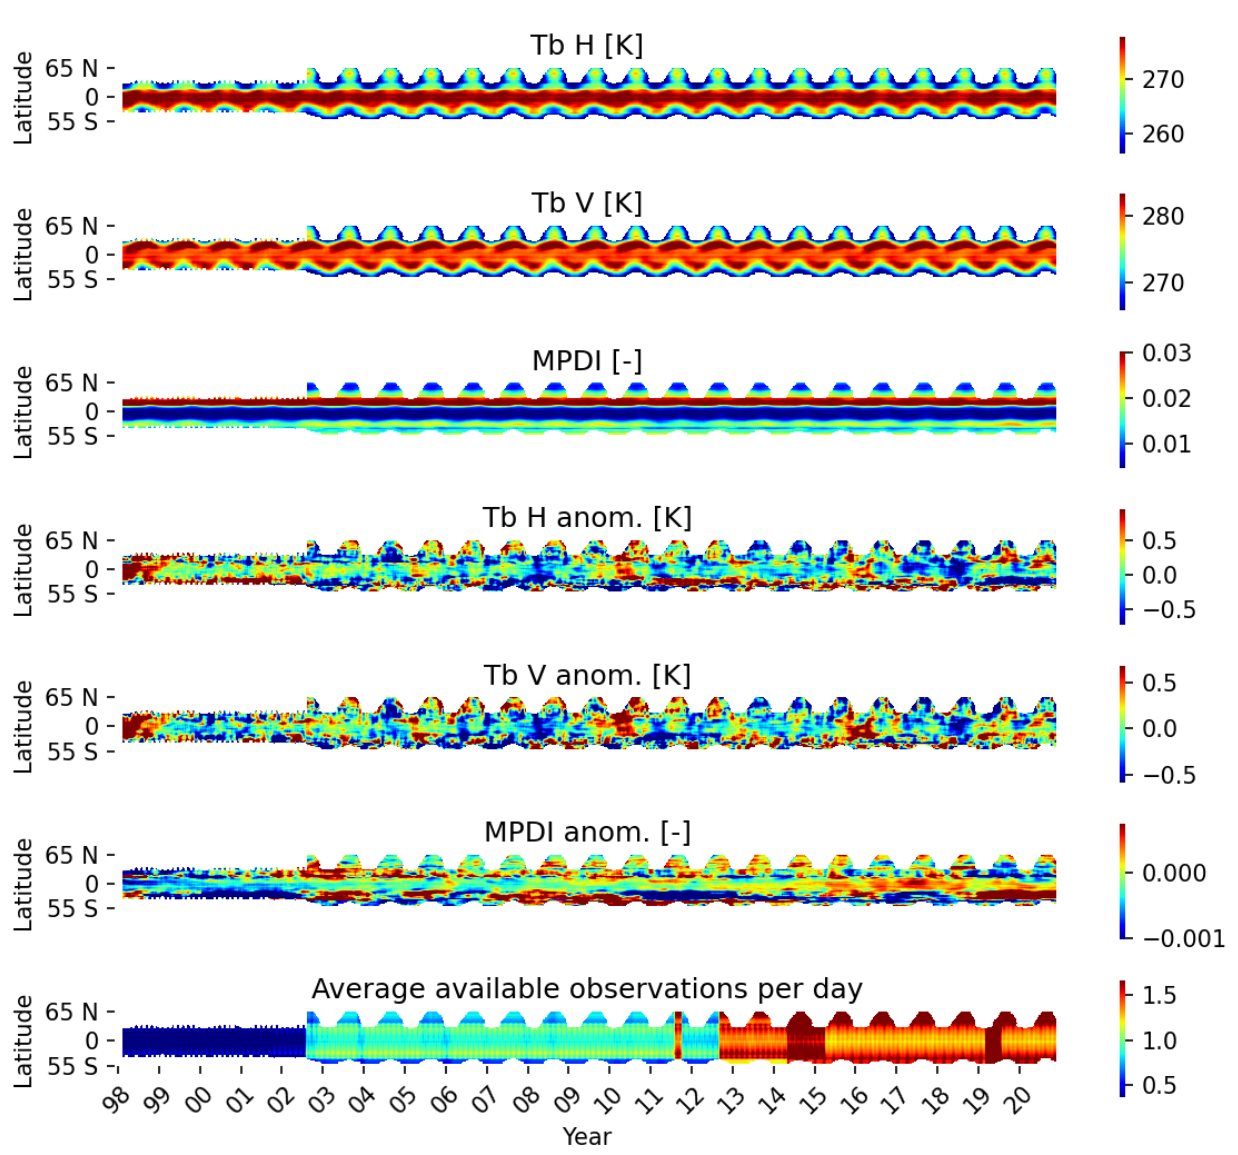
Figure 1. Hövmoller plot, a time-latitude plot, of the night-time Ka-band ICTB data that was averaged using a ±30 day moving average. Sub-freezing temperatures have been filtered out. The baseline used for the anomalies is from July 2002 to December 2020 to avoid spatial differences caused by the non-polar orbit of TRMM.